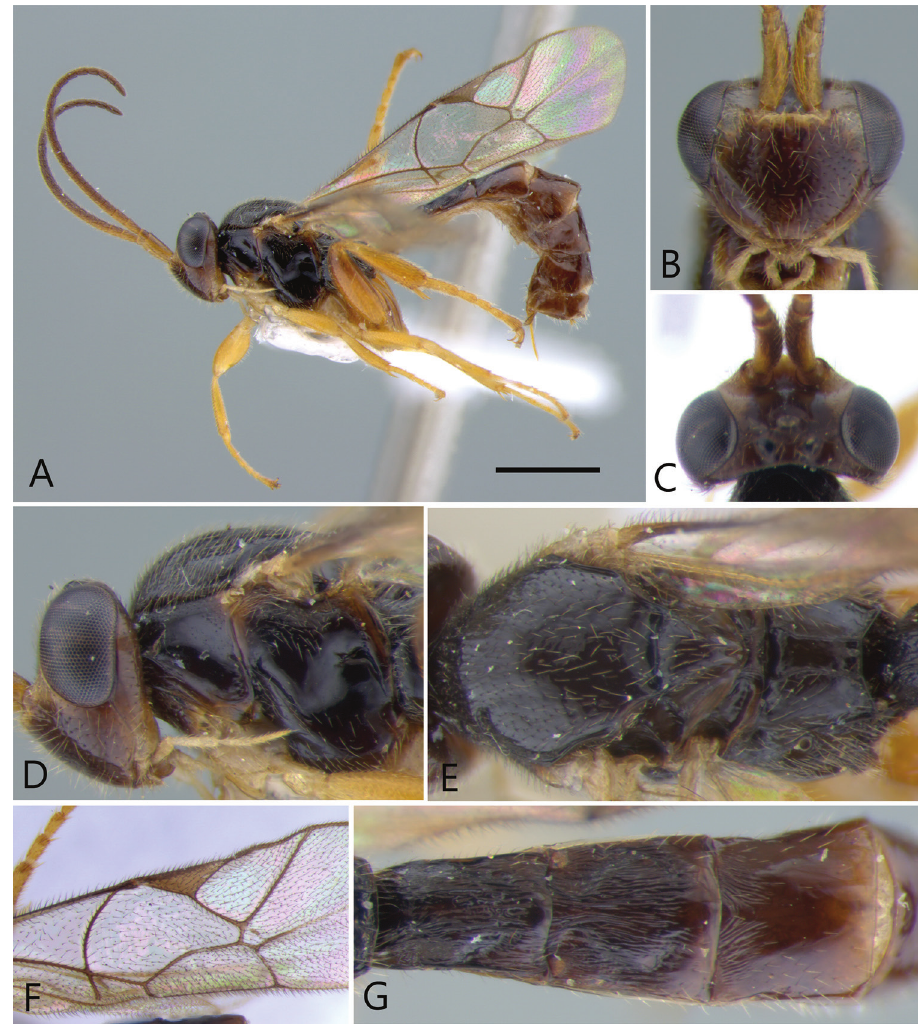
Figure 4. Orthocentrus consobrinus sp. nov. Holotype. A Habitus in lateral view B head in frontal view C head in dorsal view D head and mesosoma in lateral view E mesosoma in dorsal view F areolet G first to third tergites in dorsal